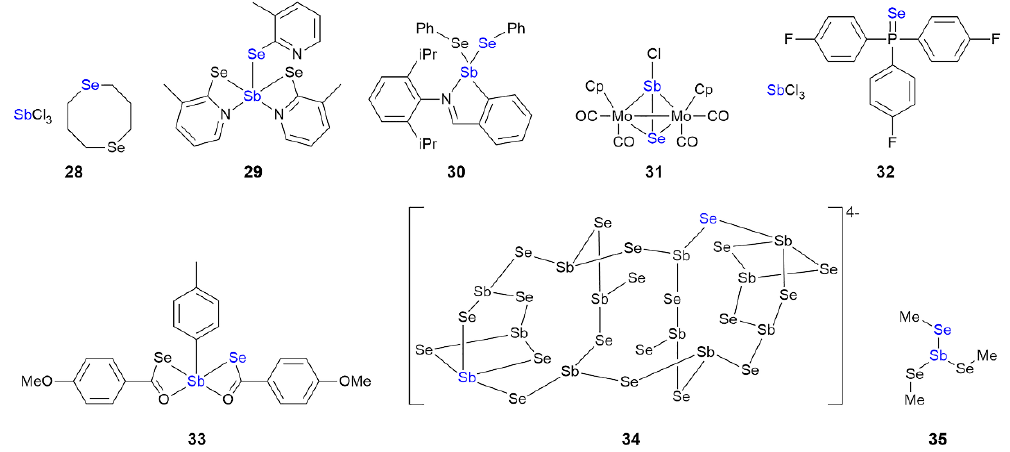
Figure 8. Chemical diagrams for antimony compounds 28 – 35 ; Cp is cyclopentadienyl.